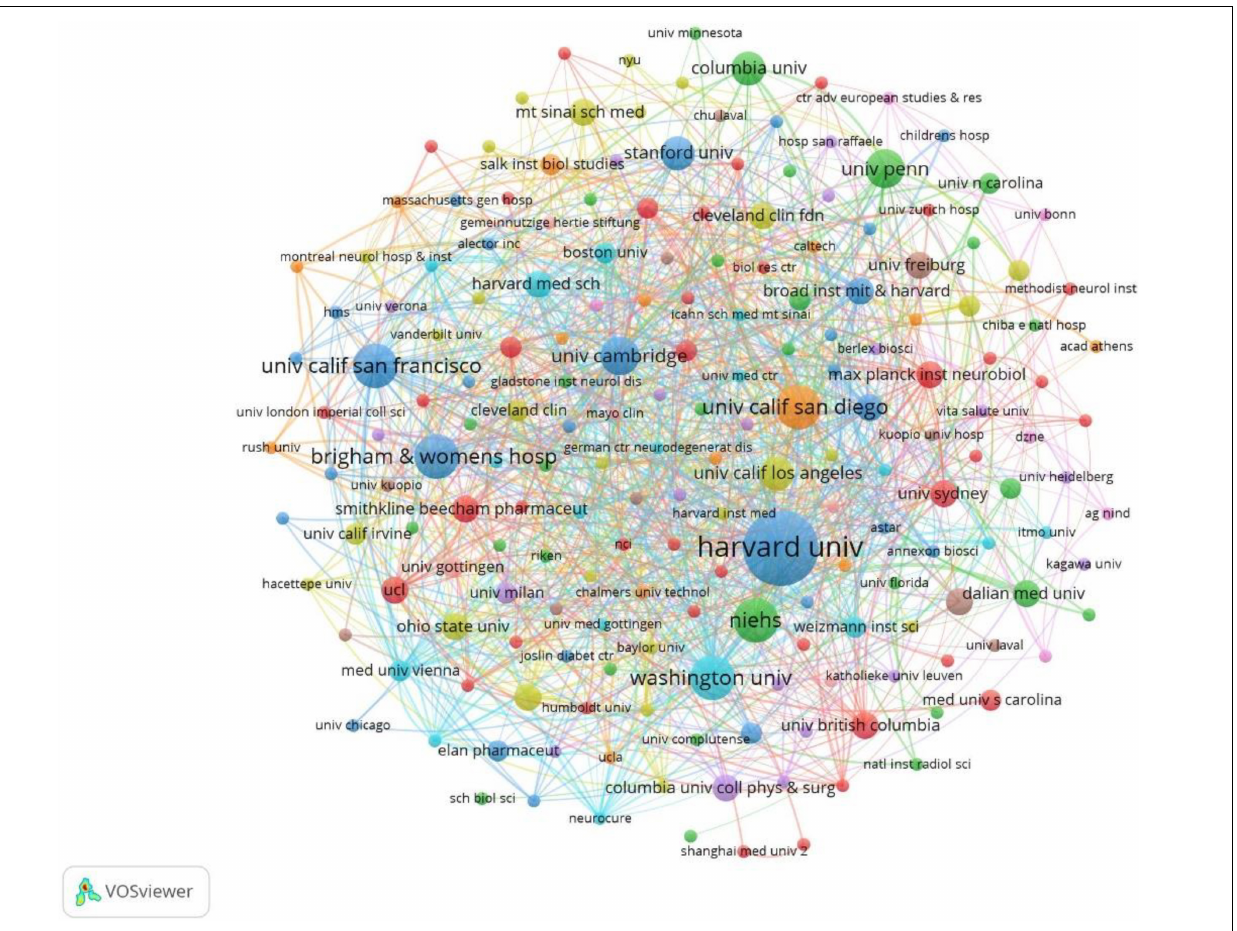
FIGURE 8 | Bibliographic coupling analysis highly cited institutions, weighted by citations, visualized map.